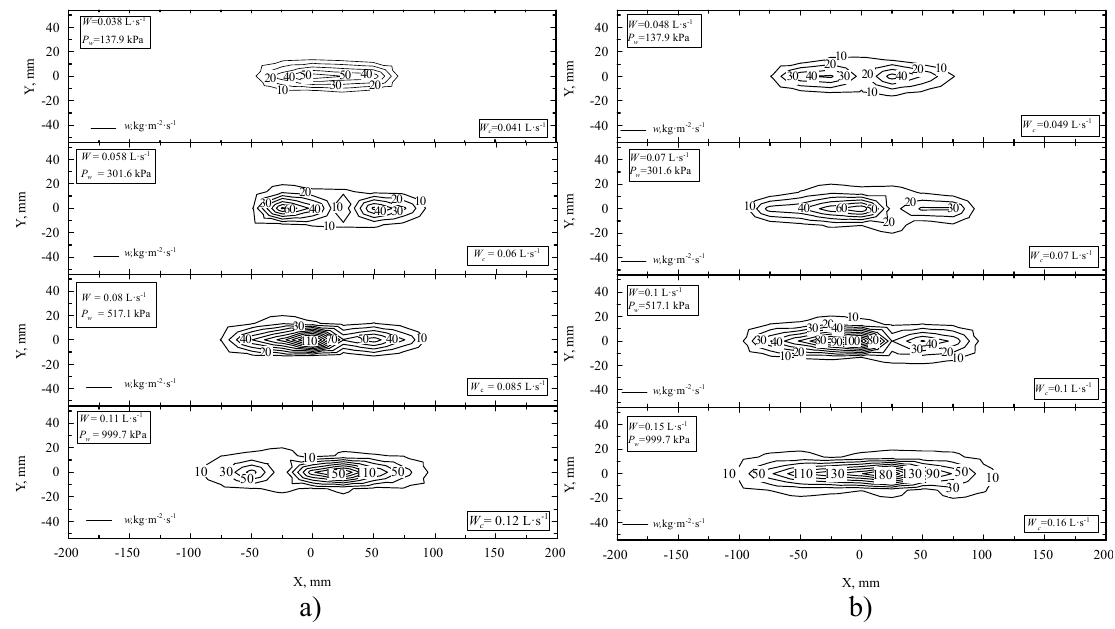
Figure 5. Effect of pressure on impingement density, ( a ) Lechler 632.604 nozzle and ( b ) Lechler 632.644 nozzle.